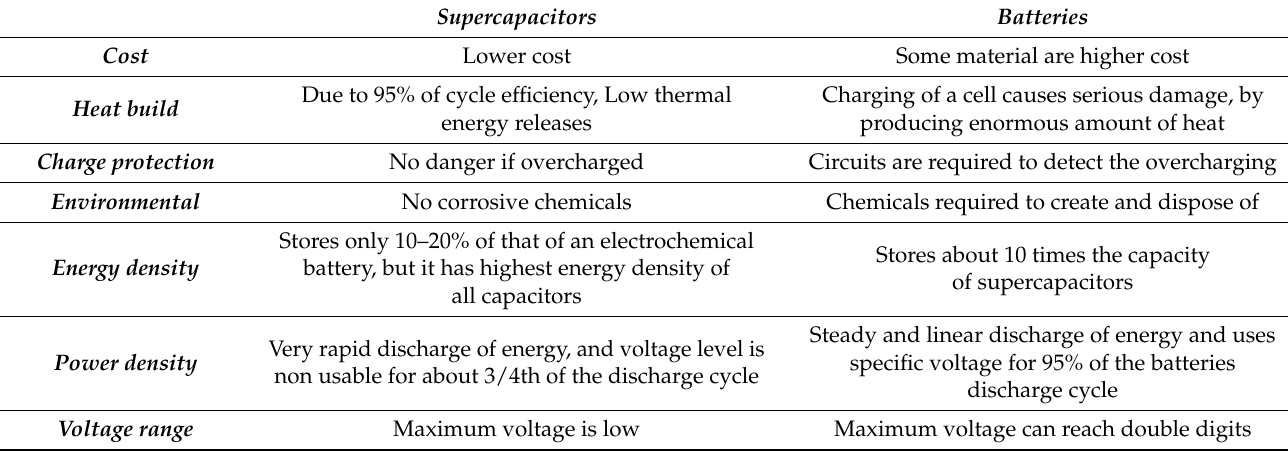
Table 2. The comparison table of supercapacitor and battery.